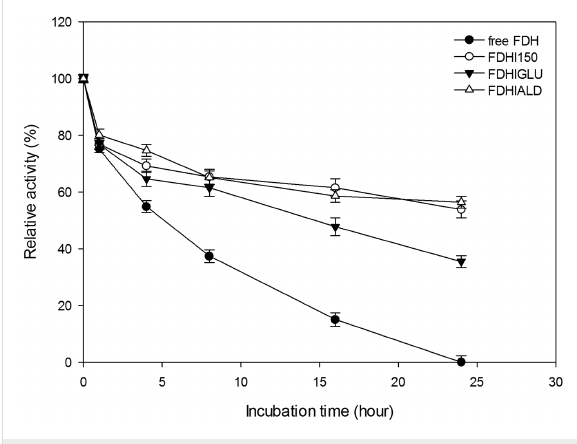
Figure 5: Thermal stability of free and immobilized FDH preparations at 50 °C.